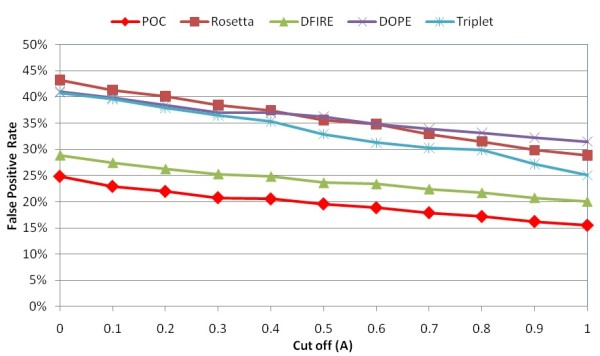
Comparison of false positive rates in POC and individual scoring functions using different RMSD cutoffs in membrane protein loop decoy sets